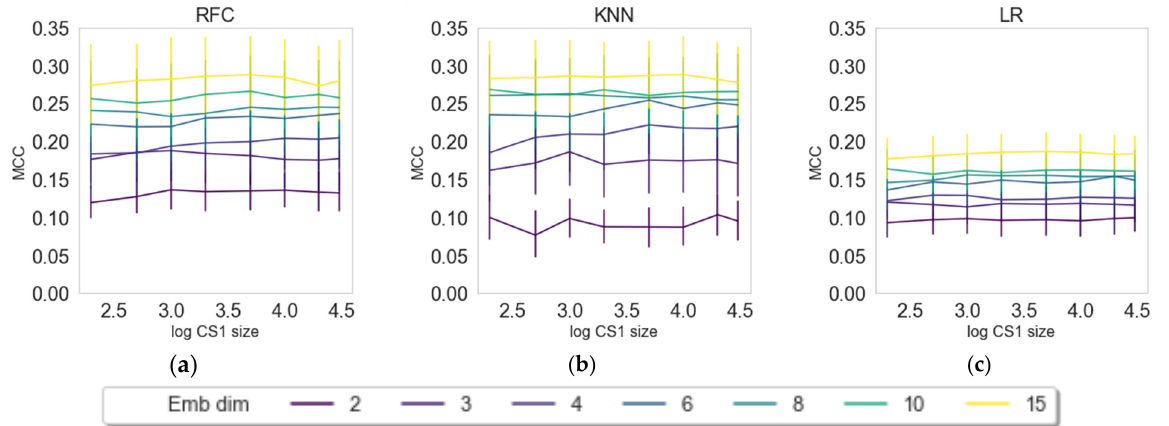
Figure 2. Dependence of classification results or transferred embeddings of CS2 by means of Matthews correlation coefficient (MCC) on the log-size of CS1 and dimensions of the PCA embeddings. The three figures represent three classifying algorithms, namely, ( a ) RFC, ( b ) LR, and ( c ) KNN.